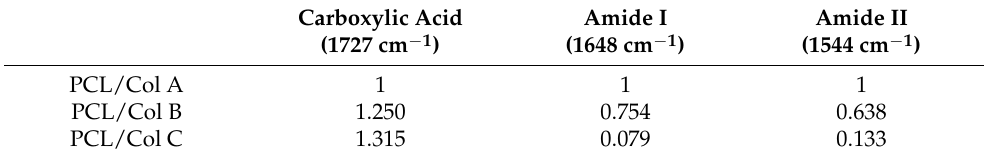
Table 1. The change in peak intensity between ART-loaded PCL/Col nanofibers with different